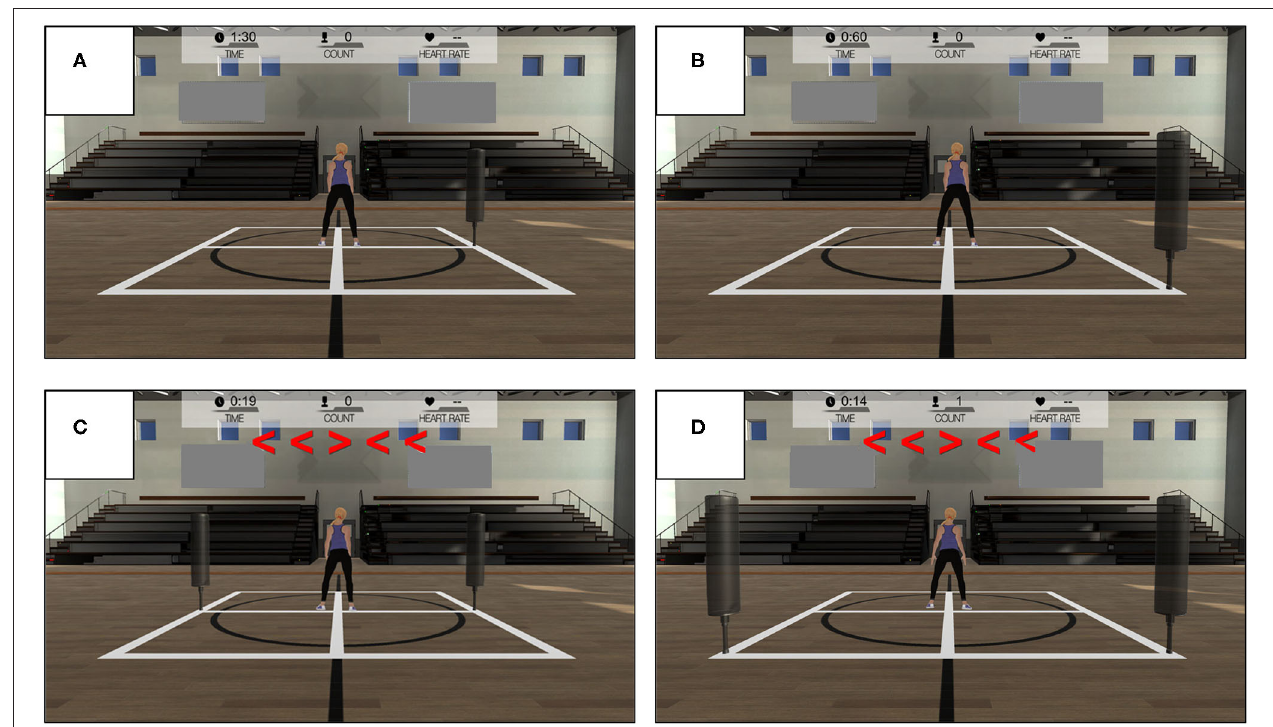
FIGURE 1 | Whole-body reactive agility test modes: (A) Lateral Single-Task, (B) Diagonal Single-Task, (C) Lateral Dual-Task, and (D) Diagonal Dual-Task.